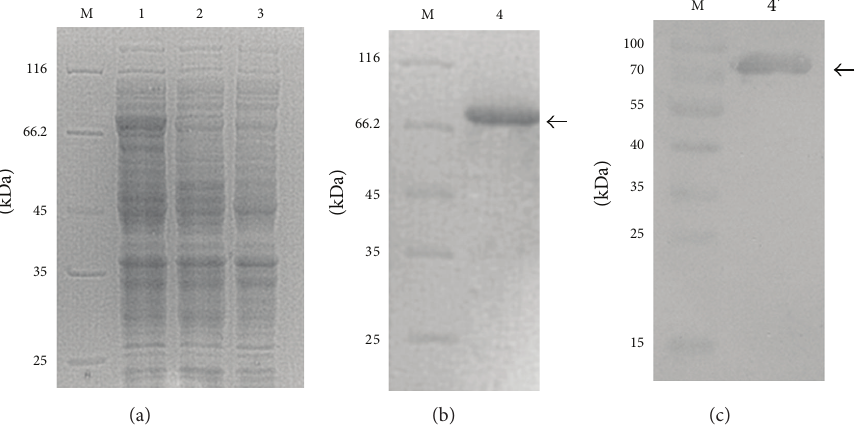
Figure 2: Expression (a), purification (b), and Western blot analysis (c) of the SP2 protein expressed in Escherichia coli . M: protein molecular weight marker; 1: recombinant bacteria after inducing; 2: recombinant bacteria before inducing; 3: empty vector after inducing; 4: purified of the fusion protein; 4 󸀠 : Western blot analysis.